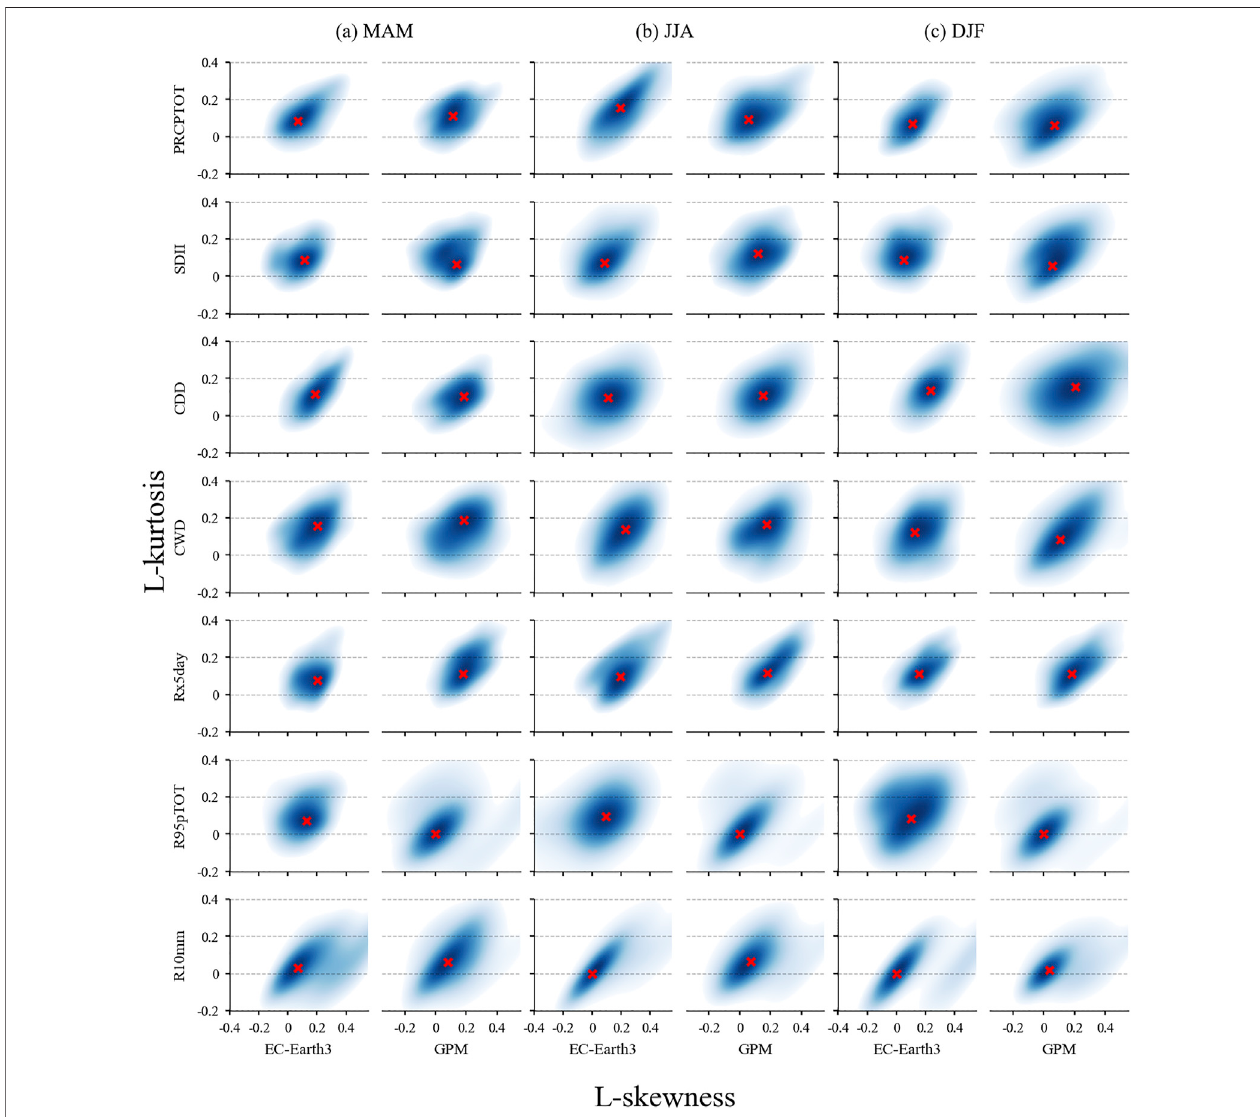
FIGURE6 | Kernel bivariate densities for asimulationof EC-Earth3 and GPM with thehighest probable region of L-skewness and L-kurtosis densities in (A) spring (MAM), (B) summer (JJA), and (C) winter (DJF).The red cross represents the highest probability region.